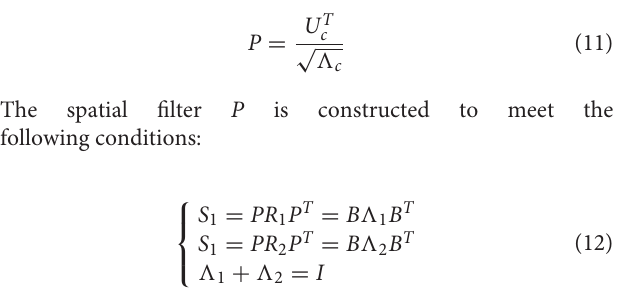
The corresponding mixed space covariance matrix is